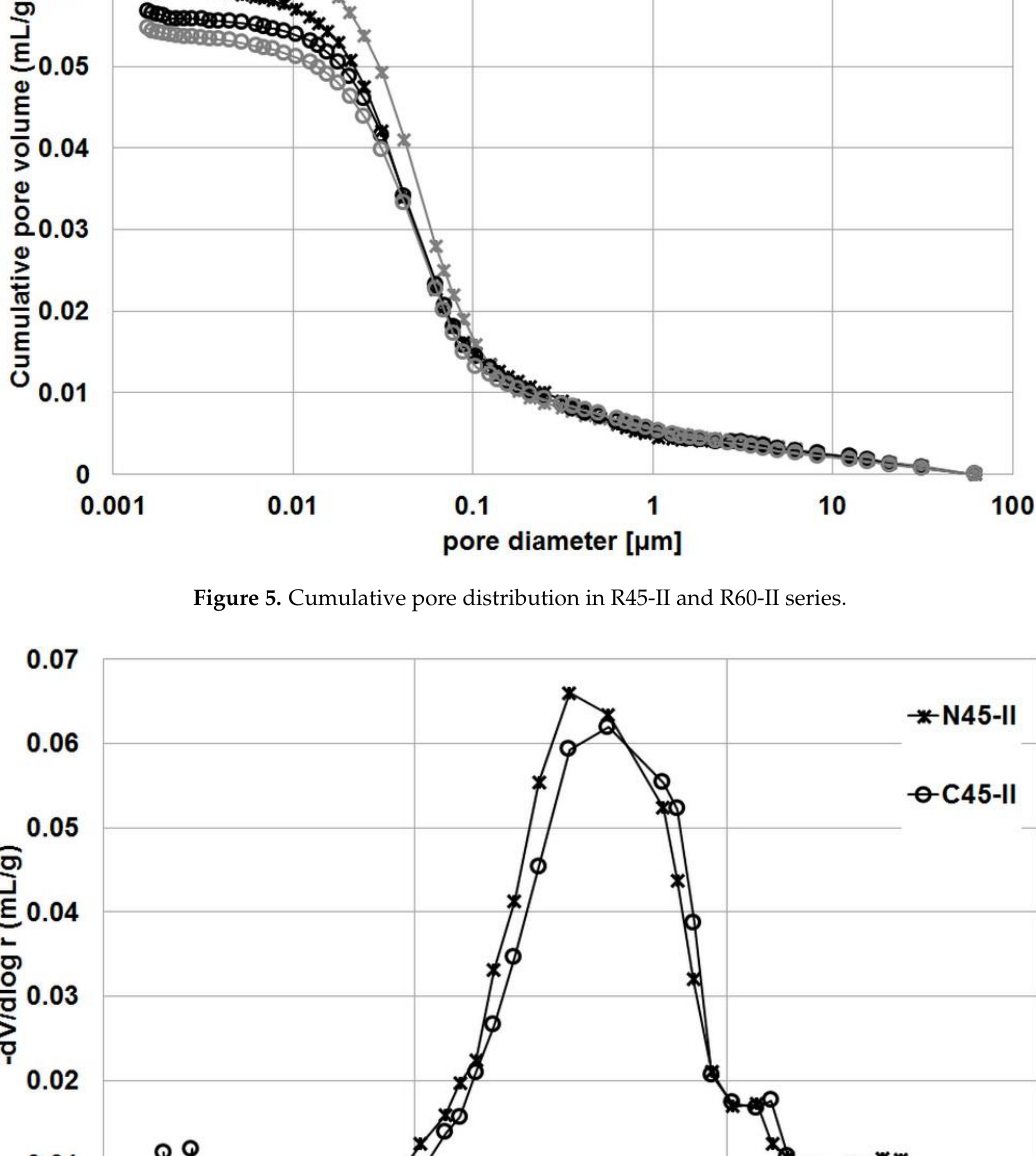
Figure 7. Pore distribution in R45-II series. 4. Summary In order to comprehensively assess the influence of various impregnation solutions on the change of the properties of the concrete with impregnated recycling aggregate, all the results obtained are summarized in Table 7 in a simplified form showing the qualita- tive impact of the various forms of the aggregate treatment.